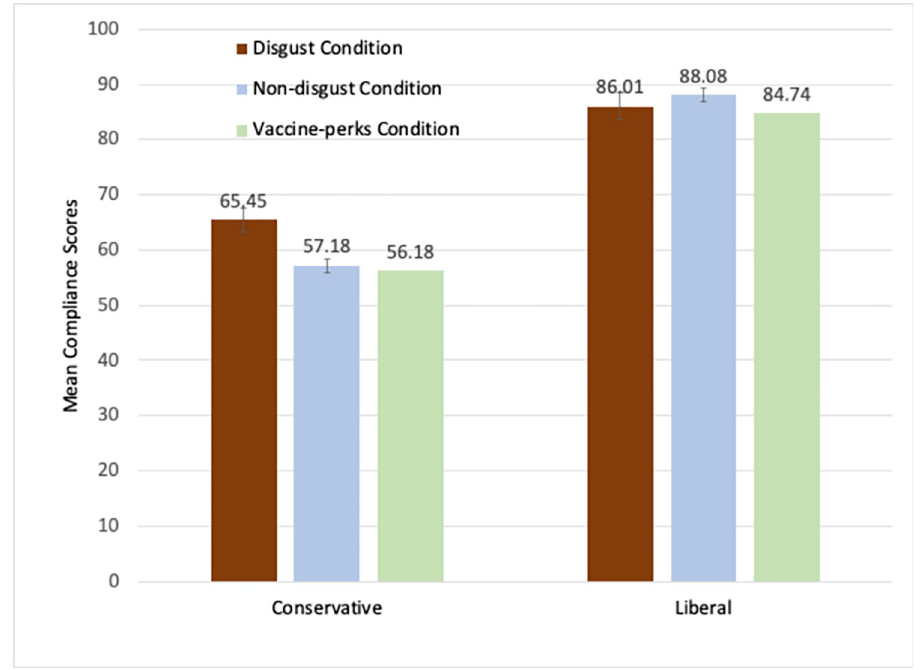
Fig 2. Mean compliance scores of the unvaccinated conservative and the liberal participants in the disgust, non- disgust, and the vaccine-perks conditions in study 2. (Note: Error bars show standard errors).